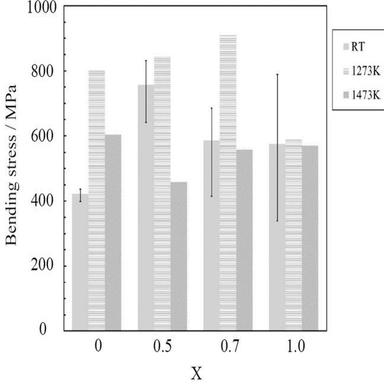
Bending stresses of TiCXN1-X-TiCrNbMoTa specimens as a function of temperature.